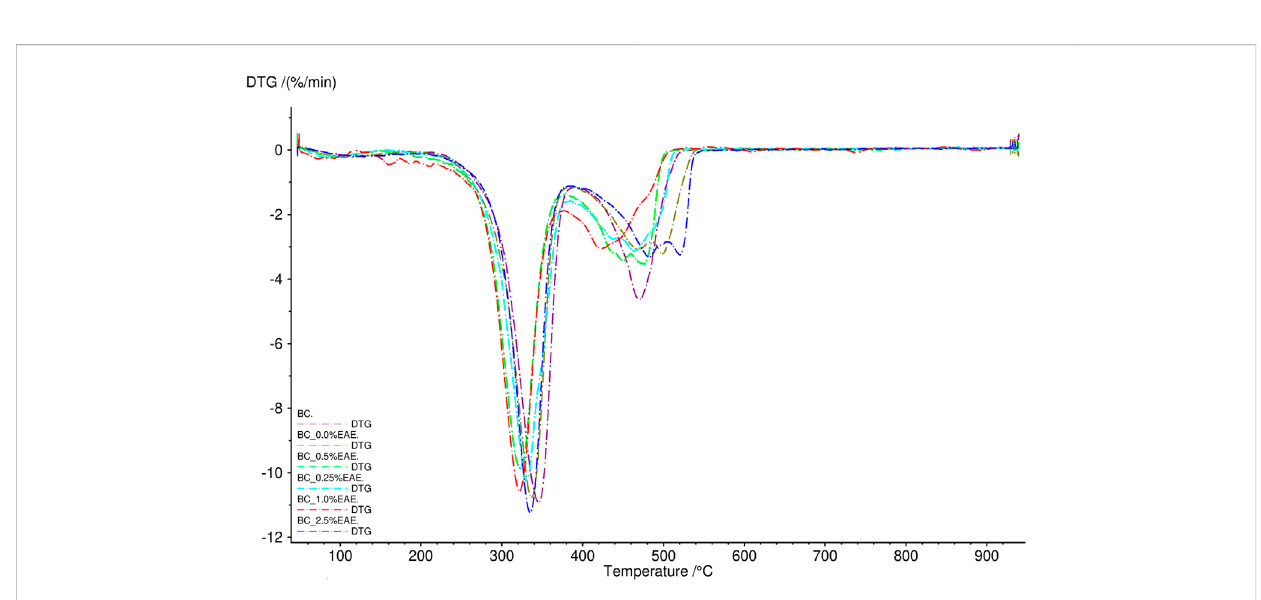
FIGURE 3 DTG curves of bacterial cellulose — BC (violet), BC-0.25%EAE (light blue), BC-0.5%EAE (green), BC-1%EAE (red), and BC-2.5%EAE (dark